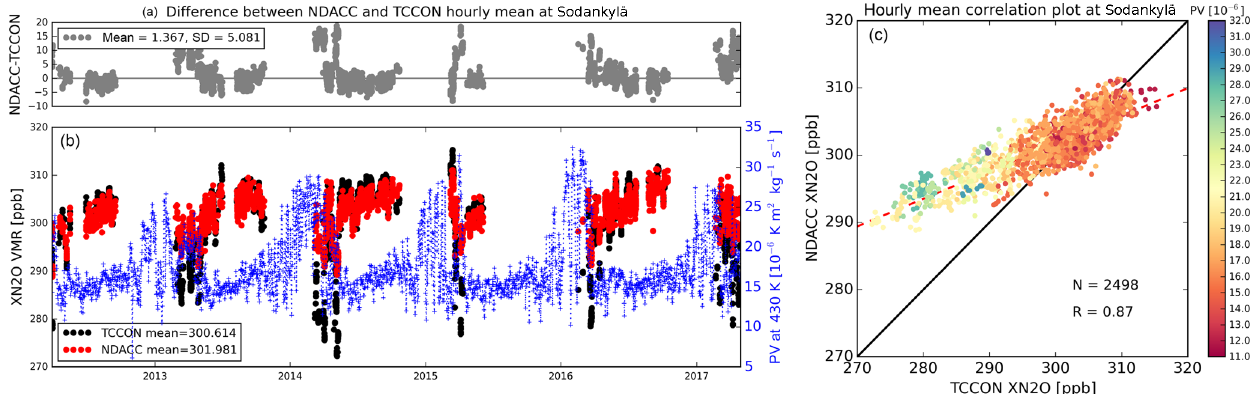
measurements at Sodankylä, together with the 2 O measurements, the blue line in (b) is the potential 2 O